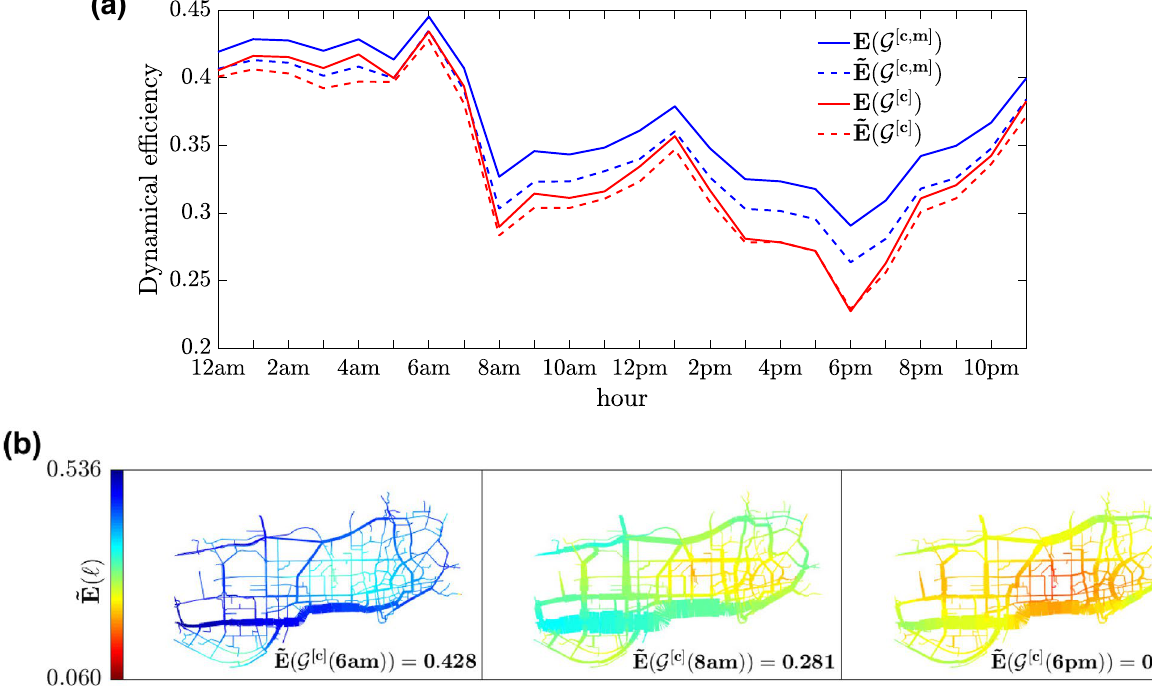
Figure 6. Daily variation and spatial distribution of weighted road efficiency. ( a ) The network dynamical [ c ] efficiency E (continuous line) and its weighted version ˜ E (dashed line) for the road network G (red) and for [ c,m ] the duplex network G (blue) are plotted at different times of the day. ( b ) Spatial maps of road weighted efficiencies. The weighted dynamical efficiency of each link has been obtained by multiplying the dynamical efficiency of the link by its estimated flow. The colors correspond to the value of the weighted dynamical efficiency of the road system and the thickness of the road to their dynamical betweenness centrality considering the available OD information. We reported three different times of the day. At 6 a.m. the network experiences low demand and high efficiency (left). At 8am, the demand grows (notice the increase in link betweenness of roads in the southern part of city highway) but not enough to create a severe congestion (middle). Finally, at 6 p.m. the congestion forces travellers to find alternative paths to the